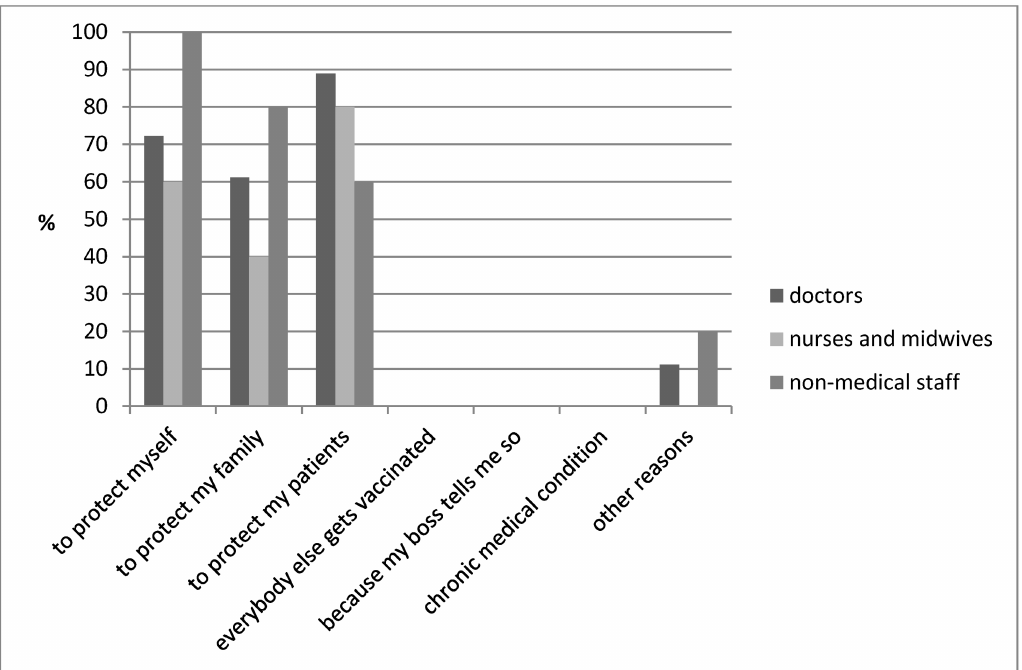
Figure 1: Vaccinated healthcare workers: reported reasons for vaccination (28 staff members responded to the question)